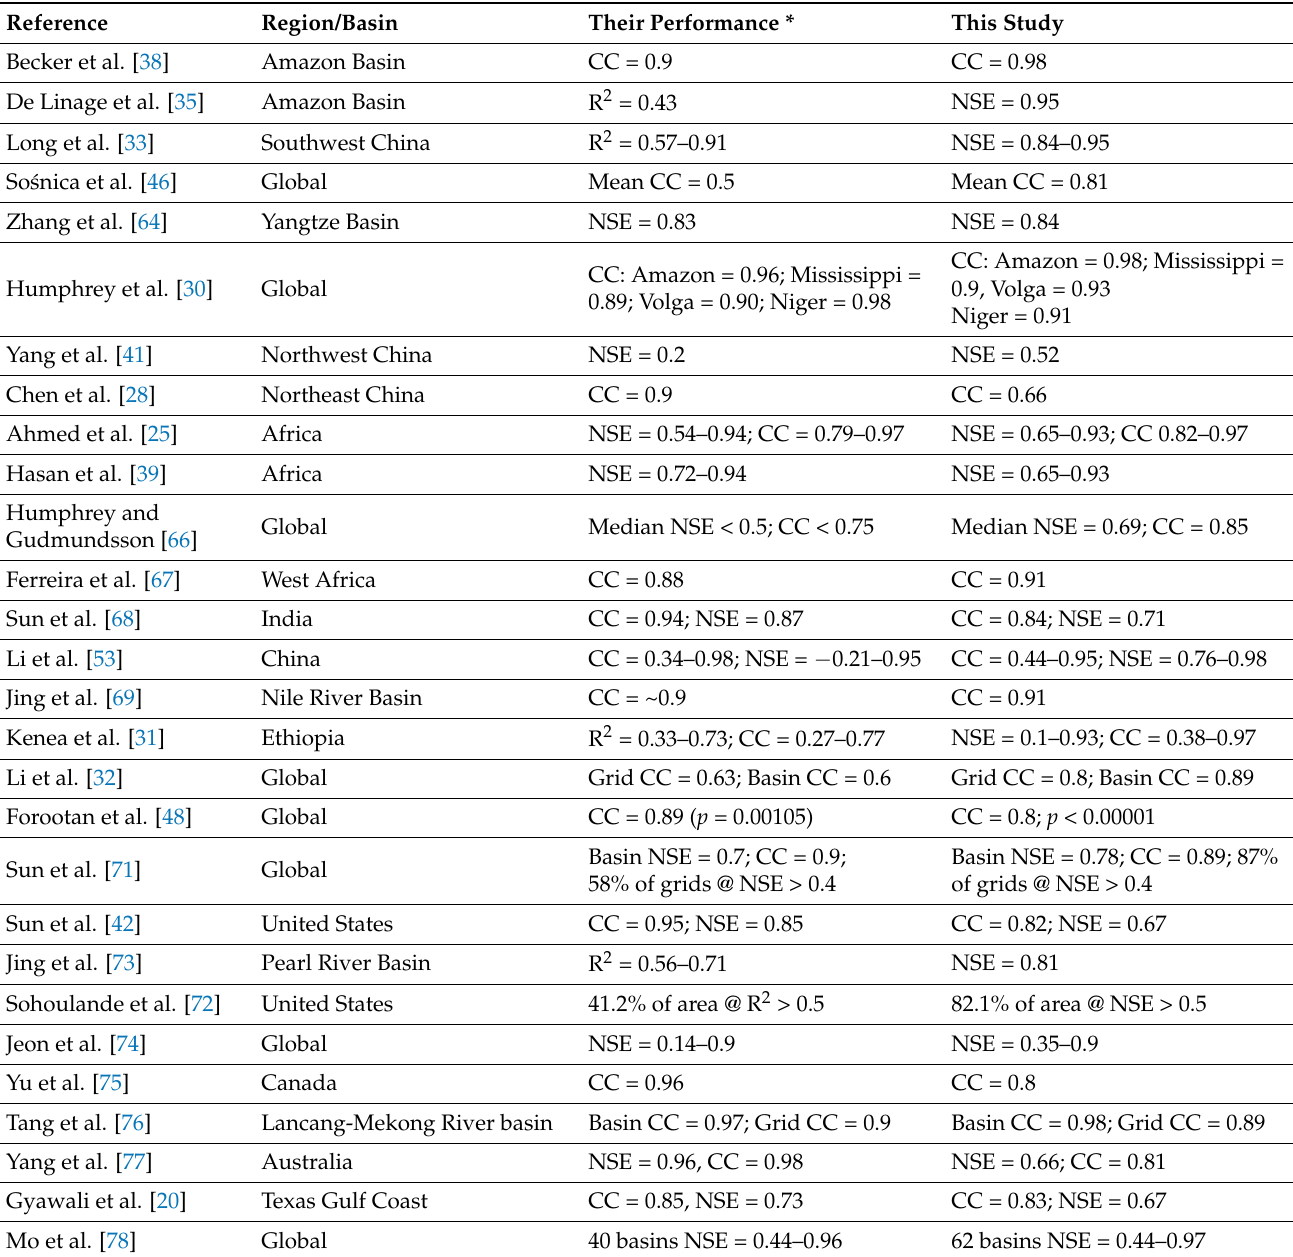
Table 3. Model testing performance comparison between this study and previous